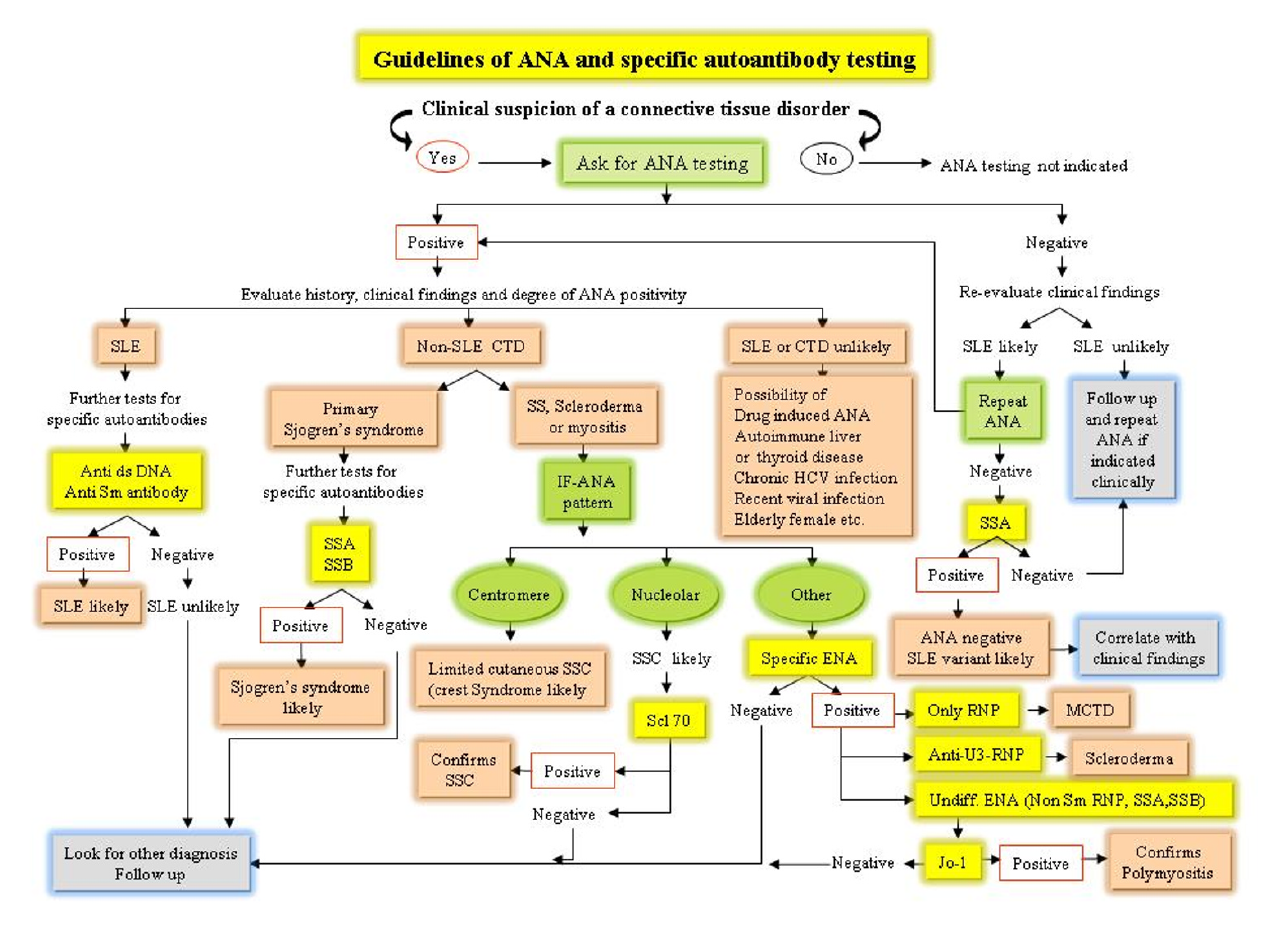
Algorithmic approach for ANA testing Figure 2